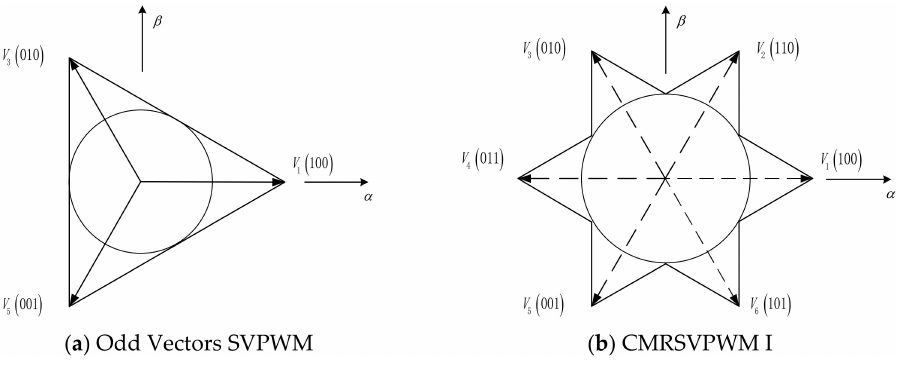
Figure 5. DC-bus utilization.